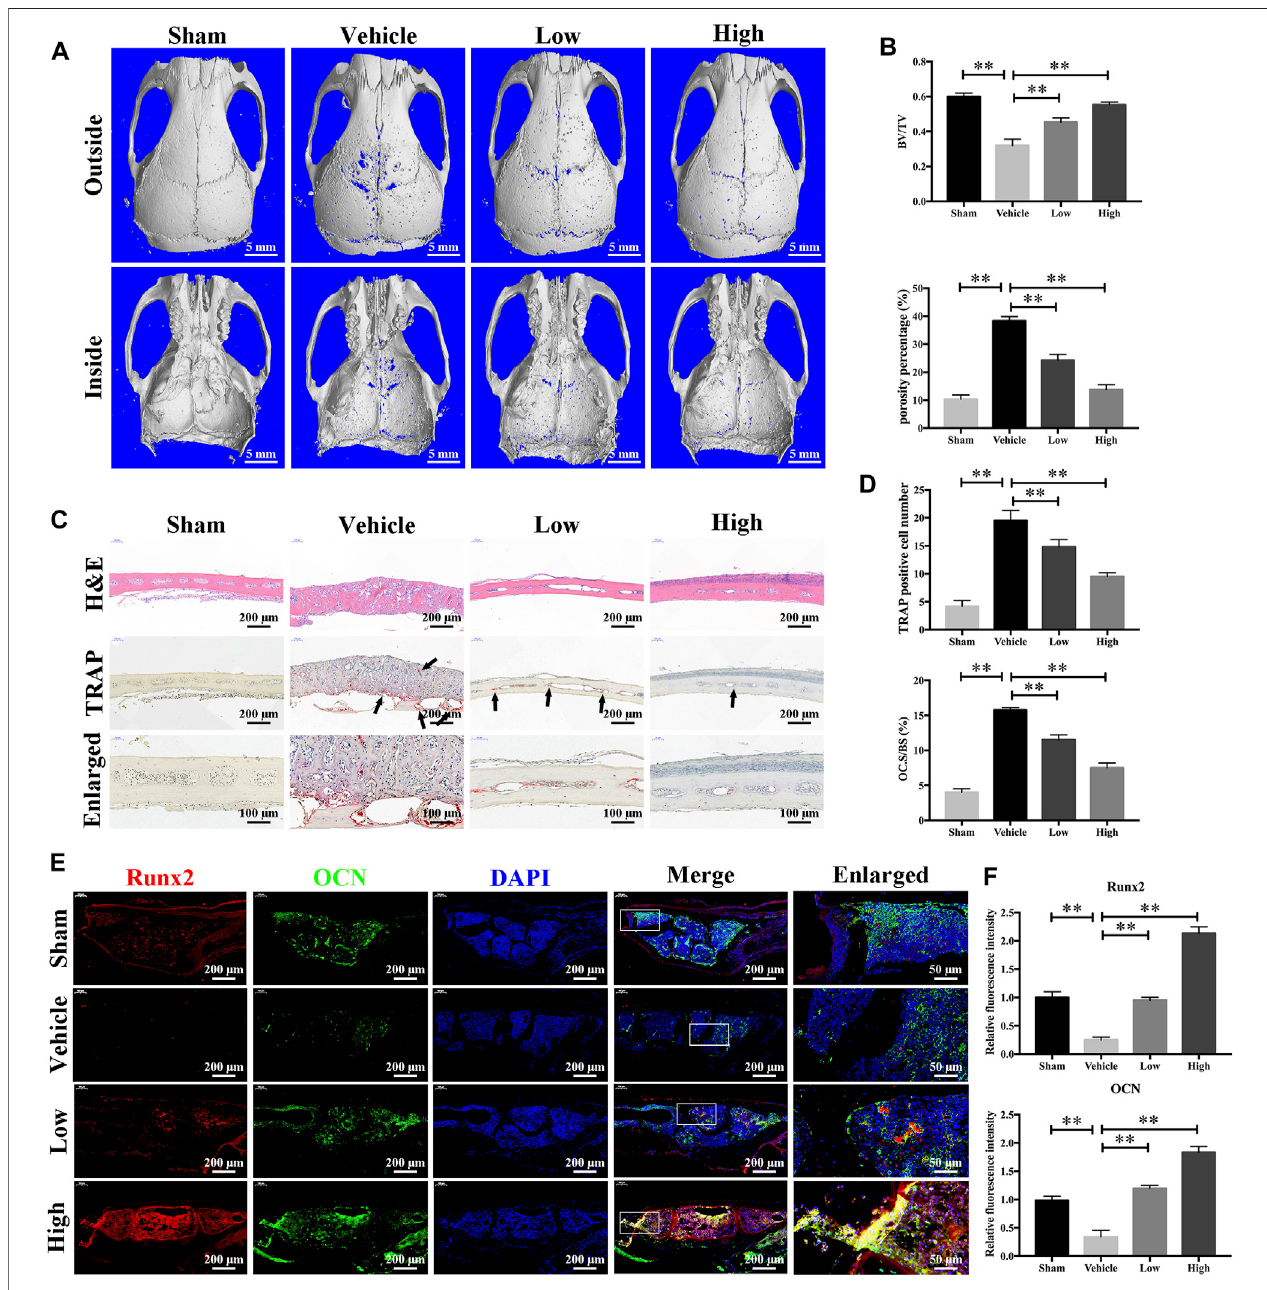
FIGURE 8 | JSH-23 prevents LPS-induced osteolysis in vivo . (A) Micro-CT scanning and 3D reconstruction of whole calvaria from the sham group (PBS), vehicle group (LPS), low group (LPS with 1 mg/kg JSH-23) and high group (LPS with 3 mg/kg JSH-23). (B) Quantitative analysis of the bone volume/total volume (BV/TV) ratio and porosity percentage. (C) Representativeimages ofcalvariastainedwithH&EandTRAPfromeach group. (D) ThetotalTRAP-positive cellnumberand theOC.S/BS percentage were quanti fi ed. (E) Immuno fl uorescence analysis of the expression of Runx2 and OCN in calvarial tissue sections from each group. (F) Quantitative analysis of the relative fl uorescence intensity of Runx2 and OCN in each experimental group. The values are shown as the means ± SDs, n (cid:1) 6; ** p < 0.01.